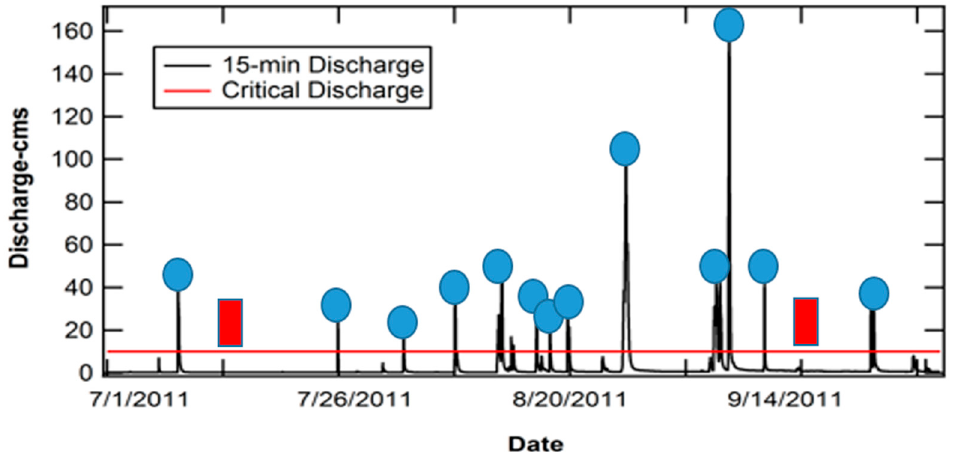
Figure 6. Fifteen-minute discharge data from 1 July 2011 to 30 September 2011 showed flash floods in Darby Creek. The Schoklitsch Equation was used to estimate critical (incipient) discharge. Boxes show two cloud-free satellite images that were captured on 14 July and 16 September.